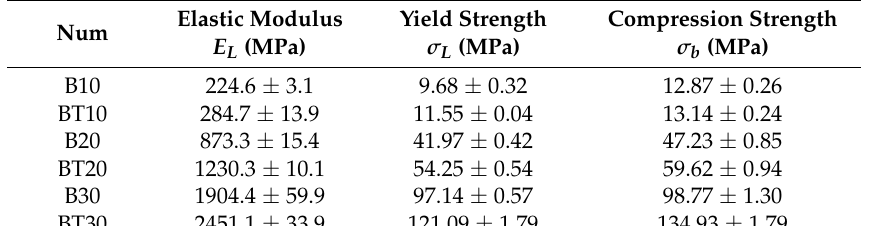
Table 2. Mechanical properties of CAD ‐ based and TPMS ‐ based samples, given as means ± standard deviations (three replicate specimens).